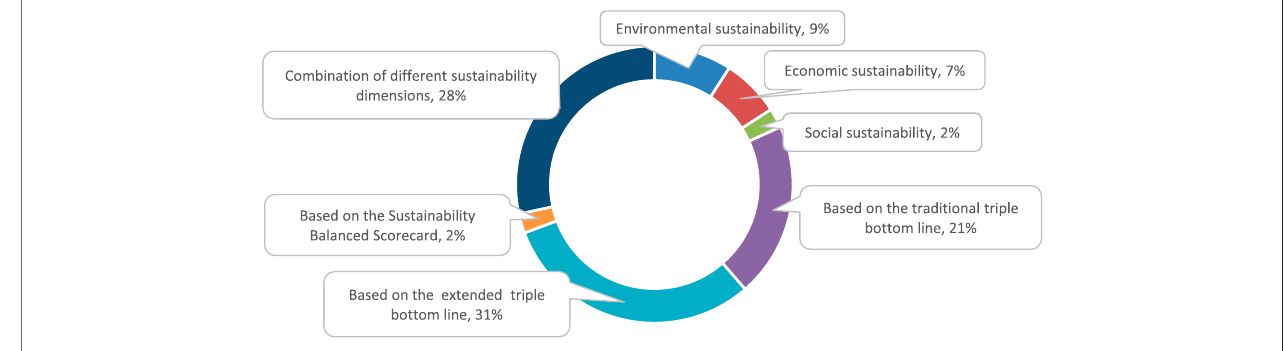
FIGURE 6 | Distribution of the evaluation framework.